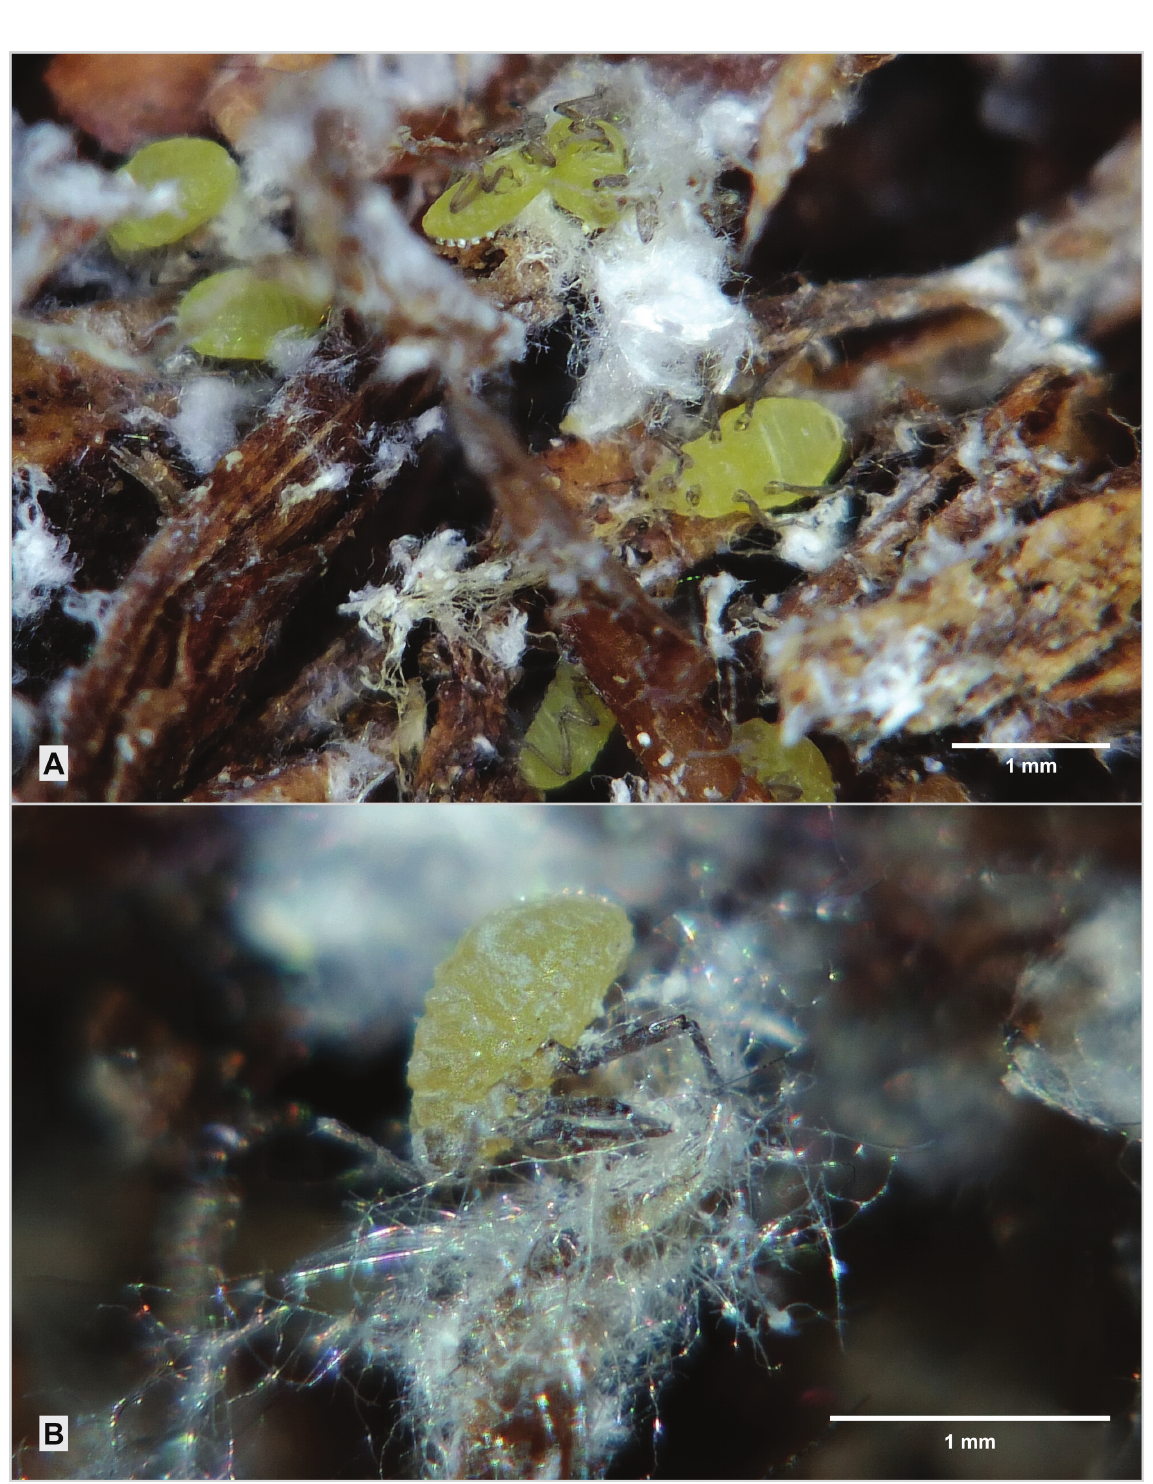
Fig. 21. Prociphilus xylostei (deGeer, 1773). A–B . Apt. on mycorrhizal Picea abies roots under Pleurozium schreberi